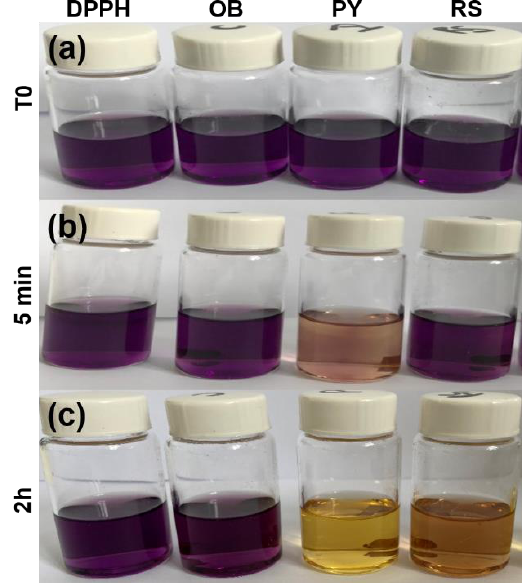
Figure 3. Digital pictures of color changes undergone by a 2,2-diphenyl-1-picrylhydrazyl (DPPH) solution (10 −4 mol/L in 70% ethanol); ( a ) before (upper row, T0); ( b ) after 5 min; and ( c ) after 2 h of contact with the different composites. Table 2. Antioxidant activity, as measured by a reduction in absorbance at 525 nm corresponding to a discoloration of 2,2-diphenyl-1-picrylhydrazyl (DPPH) solutions in contact with OB, OB@5%RS and OB@5%PY composites.